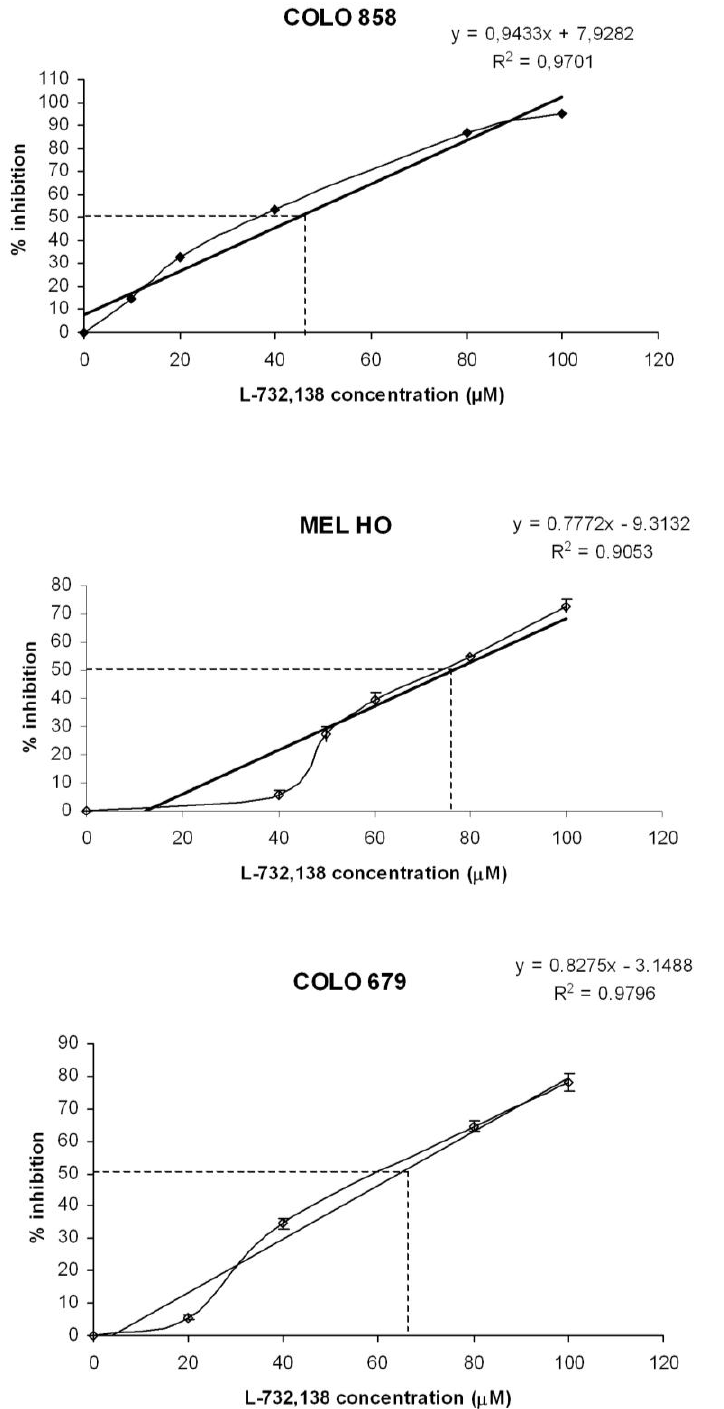
Figure 1. Percentage of growth inhibition of COLO 858, MEL HO and COLO 679 human melanoma cells at first doubling time in in vitro cultures following the addition